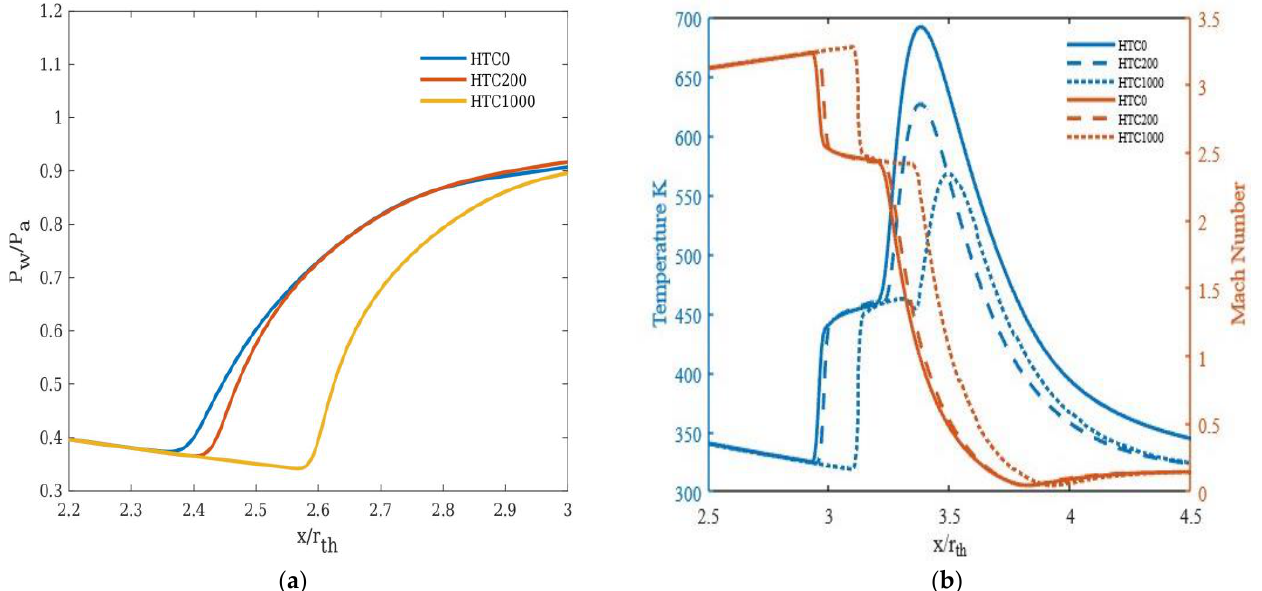
Figure 8. NPR 14 at an inlet temperature of 1000 K for different heat transfer coefficients: ( a ) Pres- sure distribution along the nozzle wall, ( b ) Temperature and Mach number variation at a distance y = 0.0015 m from the nozzle wall.